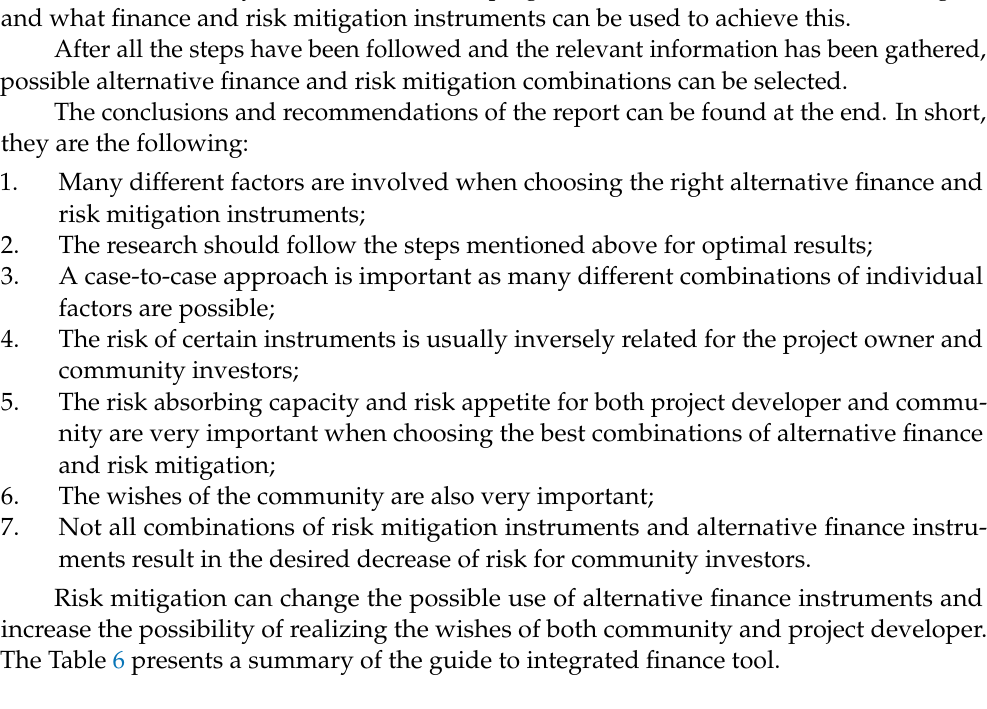
Table 6. Guide to integrated finance. Target